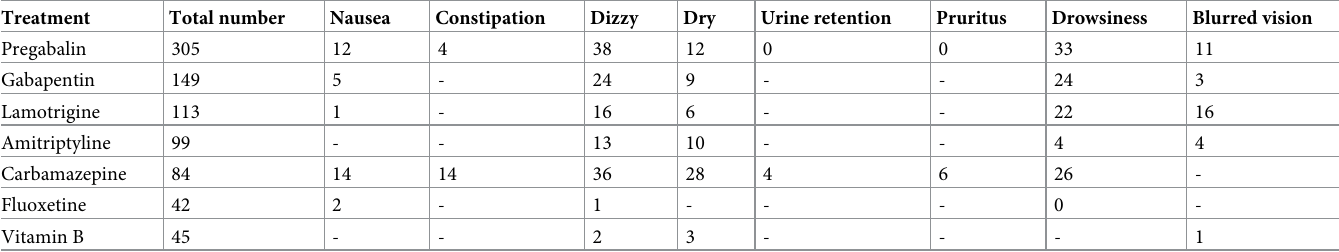
Table 5. Analysis of adverse reactions (number of events).